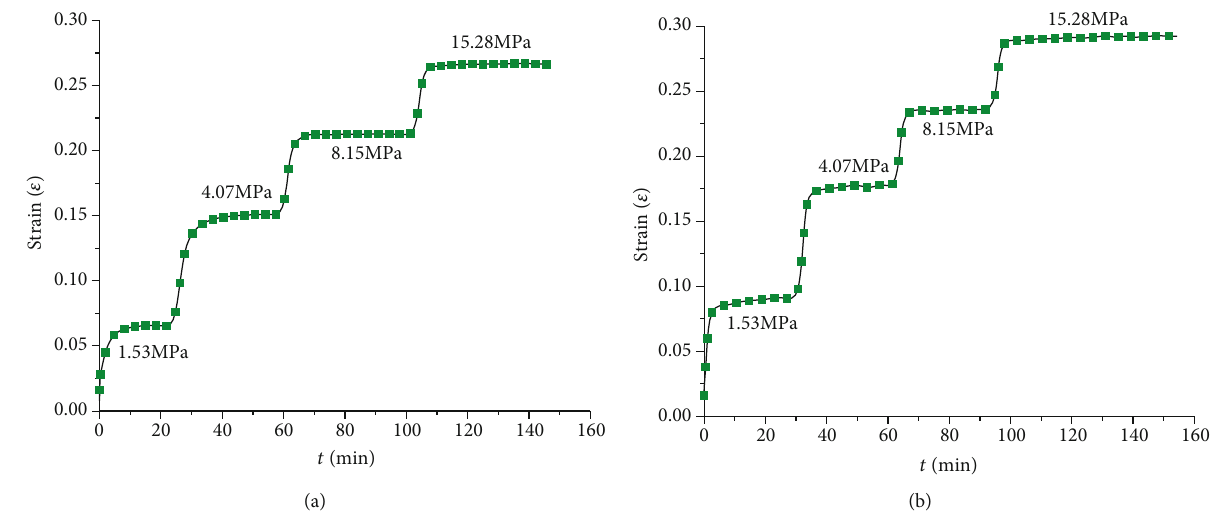
Figure 6: Rheological law of broken mudstone with di ff erent particle sizes: (a) 5-8 mm; (b) 12-15 mm. Table 2: Relationships between porosity and axial pressure of broken rock mass with di ff erent size gradations. Axial pressure